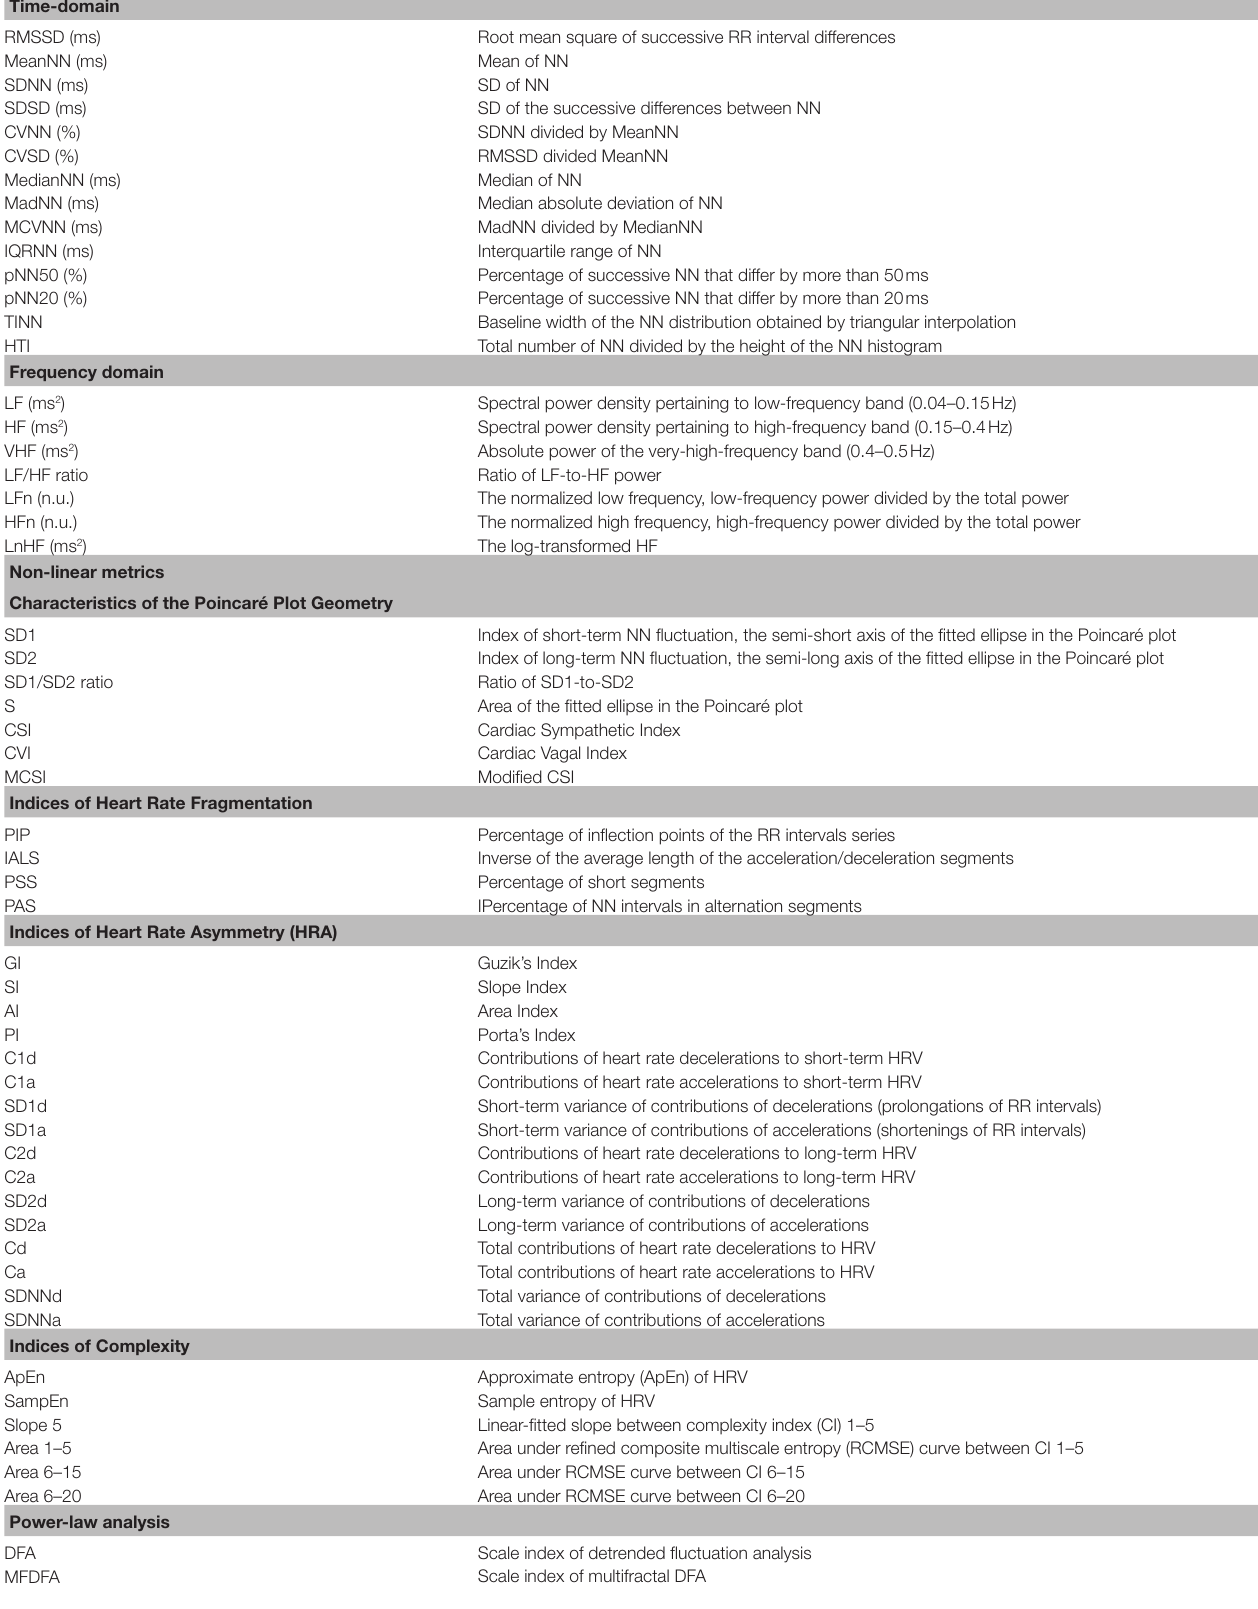
TABLE 2 | HRV metrics analyzed in this study. Time-domain RMSSD (ms) Root mean square of successive RR interval differences MeanNN (ms) Mean of NN SDNN (ms) SD of NN SDSD (ms) SD of the successive differences between NN CVNN (%) SDNN divided by MeanNN CVSD (%) RMSSD divided MeanNN MedianNN (ms) Median of NN MadNN (ms) Median absolute deviation of NN MCVNN (ms) MadNN divided by MedianNN IQRNN (ms) Interquartile range of NN pNN50 (%) Percentage of successive NN that differ by more than 50 ms pNN20 (%) Percentage of successive NN that differ by more than 20 ms TINN Baseline width of the NN distribution obtained by triangular interpolation HTI Total number of NN divided by the height of the NN